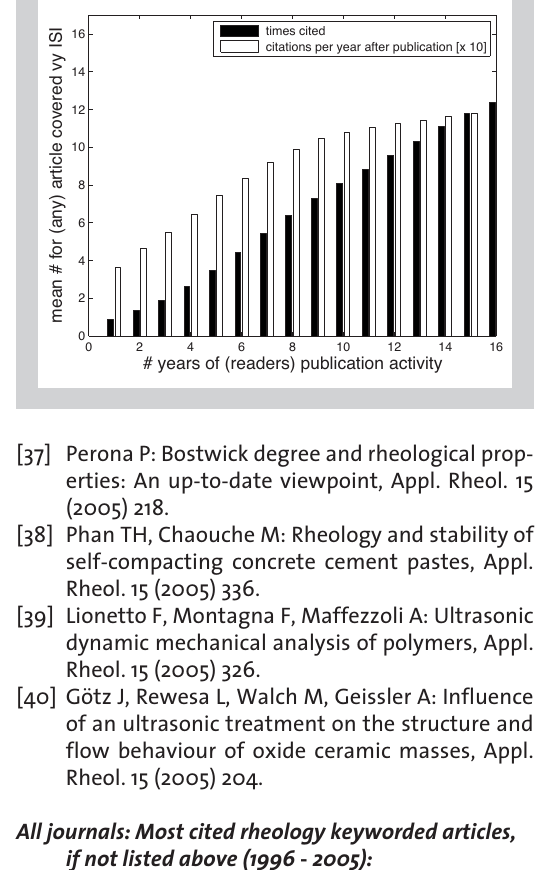
in h -journals, and covered by ISI, the reader can easily estimate the current and future relative impact of her/his articles by using this graph as described in the final text